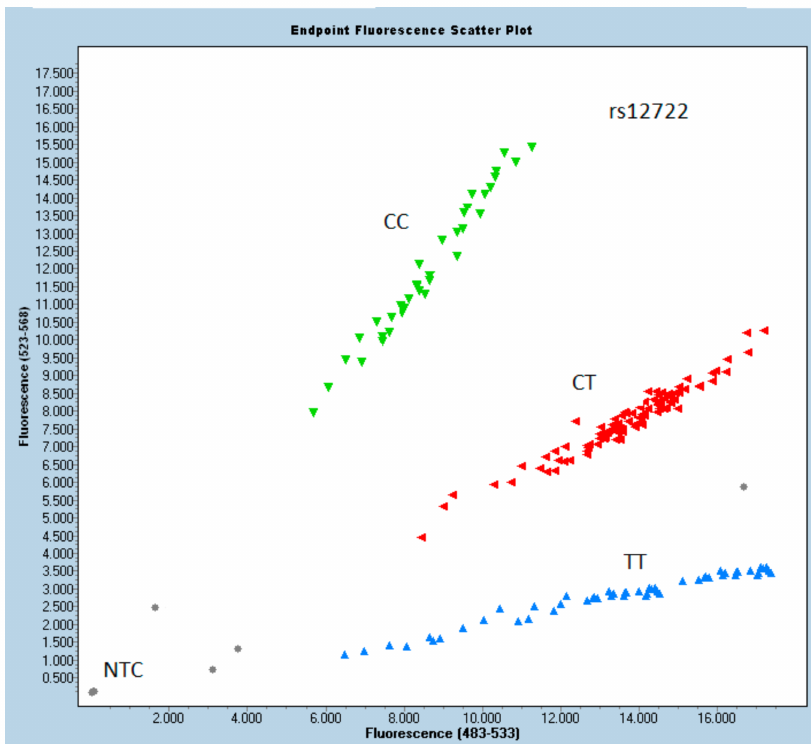
Figure 2. Allelic distribution plot of rs12722genotypes in the study and control